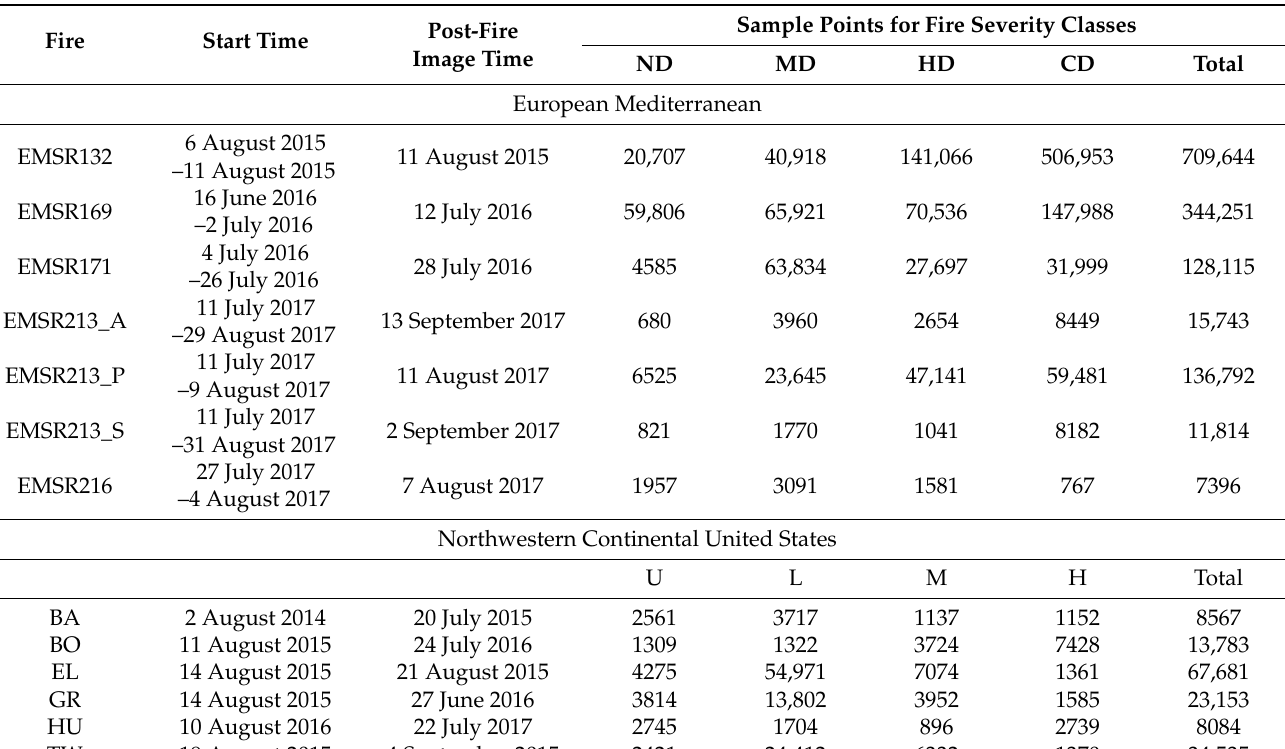
Table 1. The occurrence times of all 14 fires, the acquisition times of the corresponding remote sensing images, and the number of sample points for fire severity